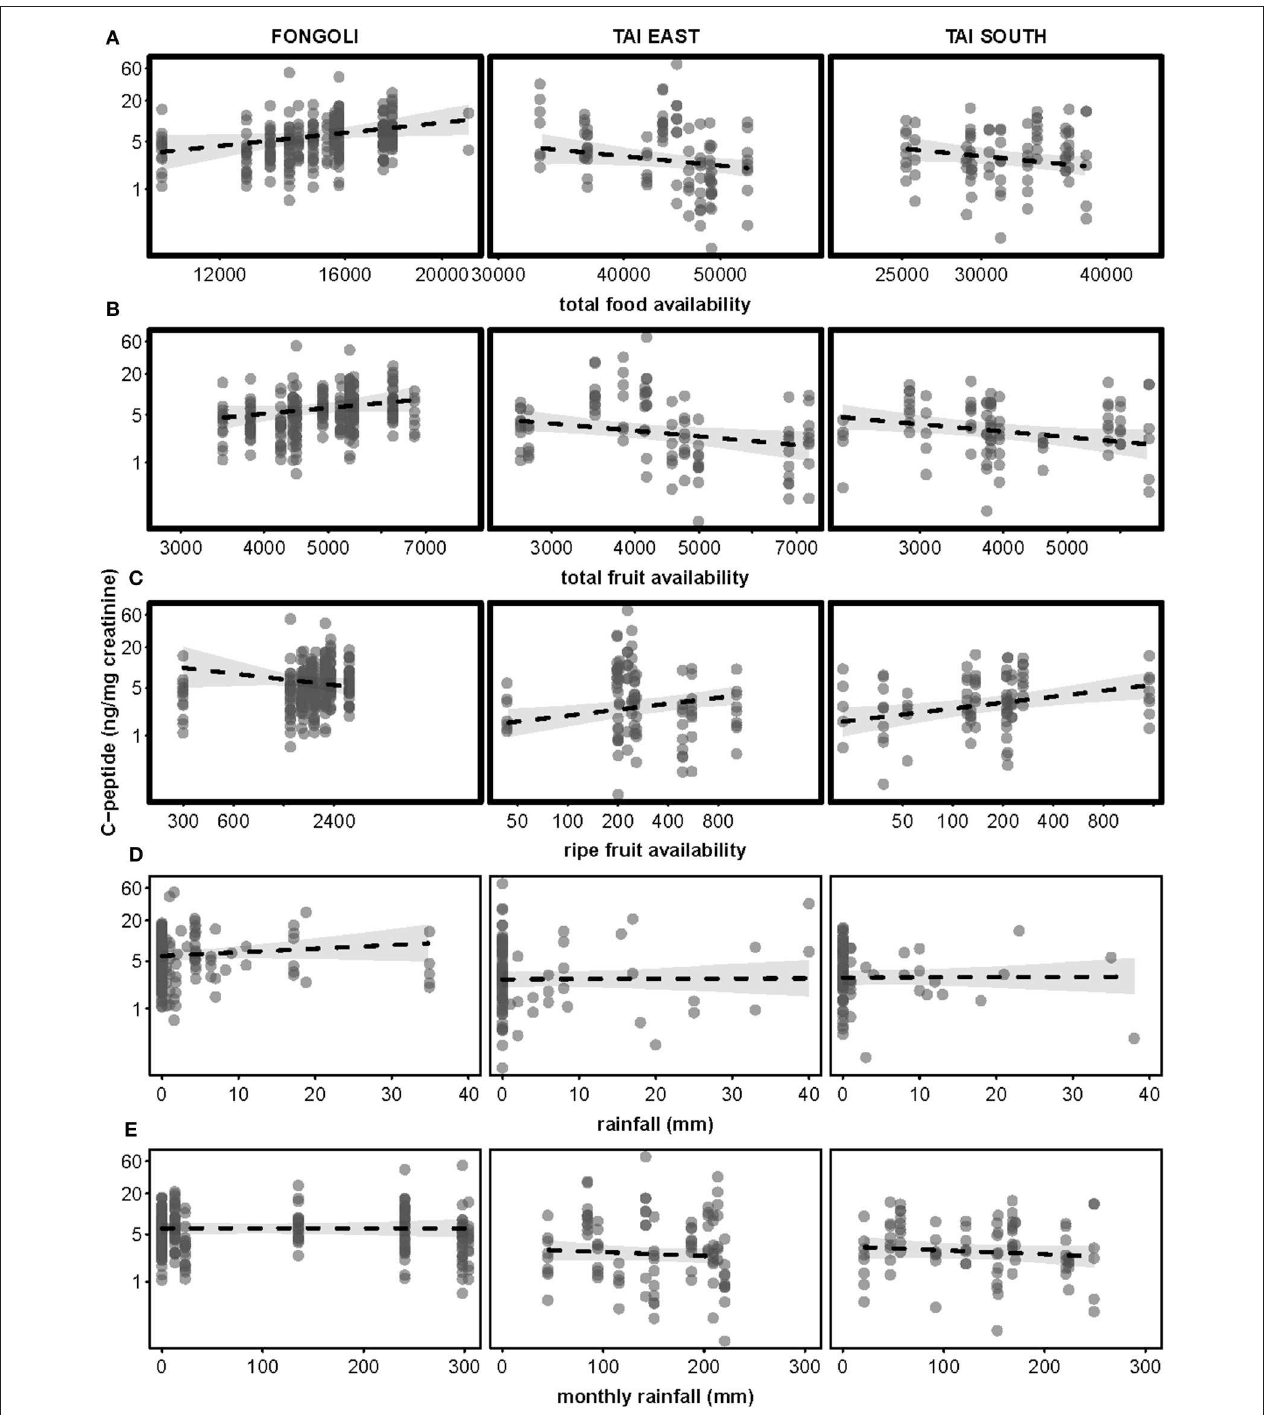
FIGURE 6 | Effects of five environmental variables on urinary c-peptide levels in three chimpanzee communities. Environmental variables displayed are: total food availability ( A , centered to community), total fruit availability ( B , centered to community), ripe fruit availability ( C , centered to community), rainfall (D) , and monthly rainfall (E) . C-peptide levels are displayed on a logarithmic scale. Statistically significant inter-site differences ( p ≤ 0.05) appear with bold margins; 95% confidence intervals are displayed in gray.